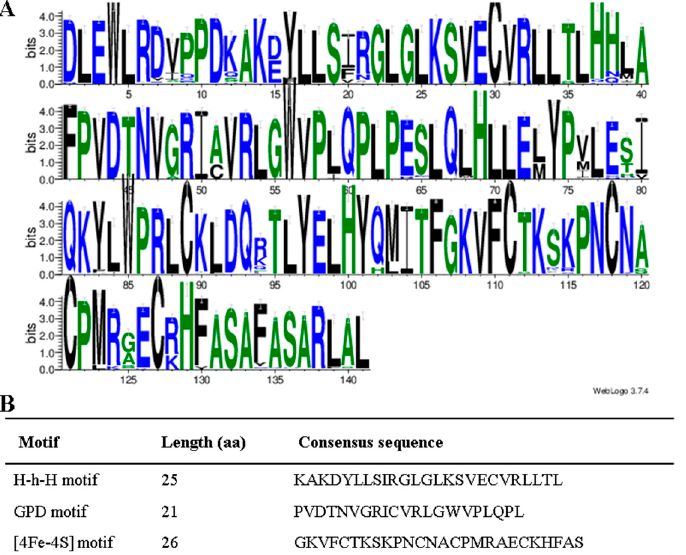
Figure 3. Conserved domain analysis of DNA glycosylase. ( A ) The conserved domain analysis of DNA glycosylase by the WebLogo program. The letter height shows the amino acid residue at each position designating the conservation degree. On the x -axis, numbers represent the sequence position in the corresponding conserved domains. The y -axis indicates the information content calculated in bits. ( B ) The consensus sequences of three motifs in the glycosylase domain.